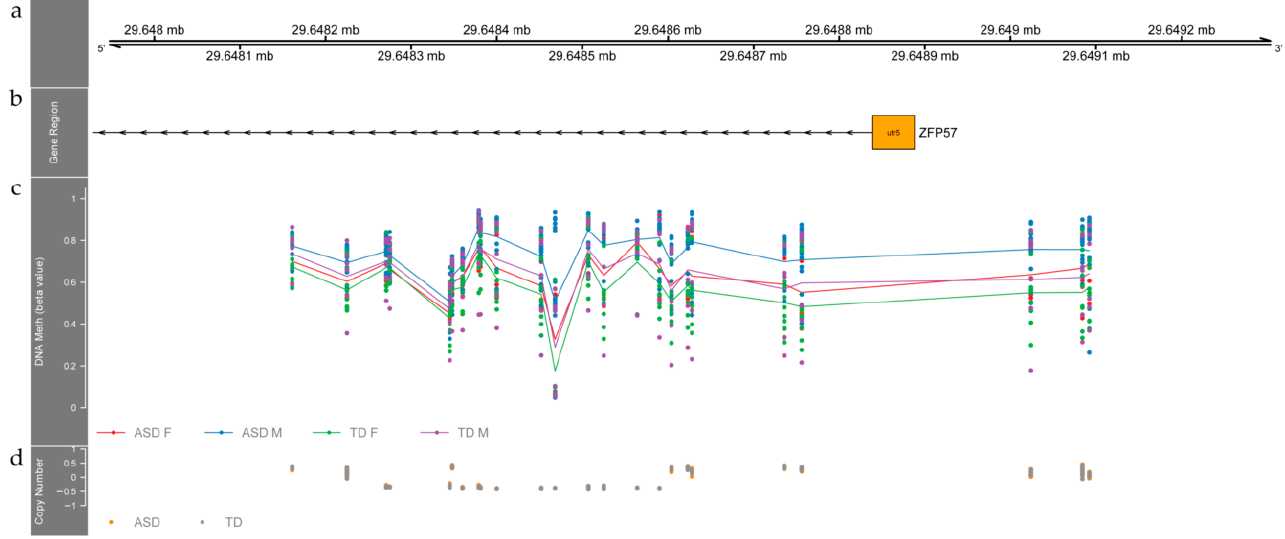
Figure 2. A genome-wide differentially methylated region (DMR) located in the 5 ′ UTR region of the ZFP57 gene is hypermethylated in buccal cells tissue from autistic individuals. ( a ) Upper panel depicts coordinates in chromosome 6 (hg19). ( b ) Represents the corresponding annotation data according to BioMart database. ( c ) Methylation data are shown as beta values, smoothed lines denote mean methylation levels for female ASD (red), male ASD (blue) and typically developing males (purple) and females (green). Each point represents the methylation level of a particular individual at a specific genomic location. ( d ) Copy number estimate obtained by calculating the difference between total probe intensity for a given individual and the mean total intensity across all individuals for a given probe. ASD subjects in orange, TD in gray.